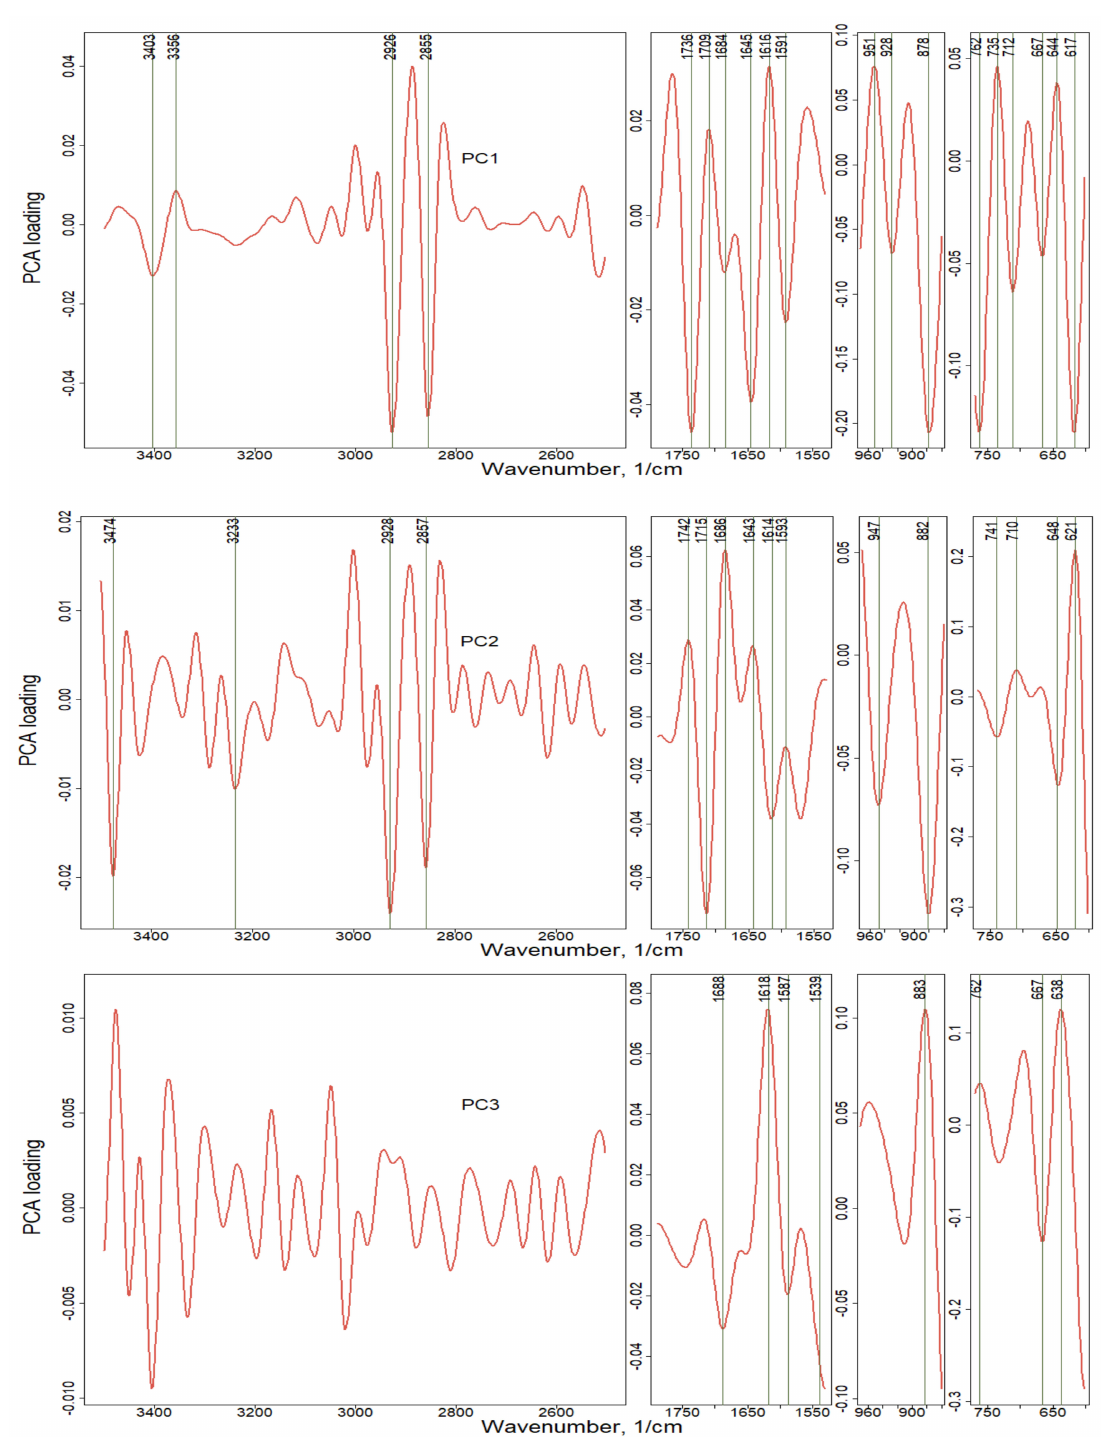
Figure 8. PC1, PC2, and PC3 loadings. Marked extremums are the absorption bands identified on FTIR spectra of daily